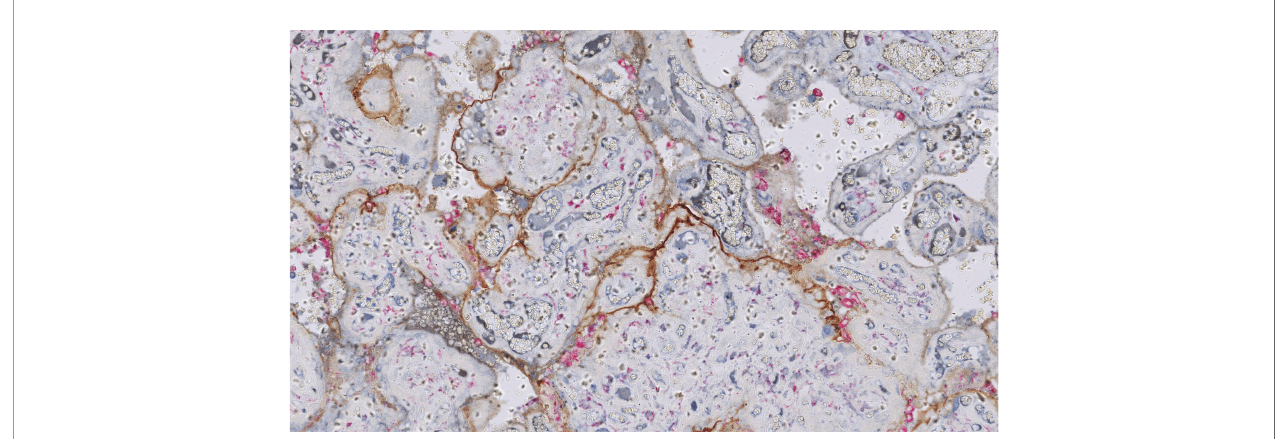
FIGURE 4 | Chronic histiocytic intervillositis (CHI). Dual staining demonstrates aggregates of CD68+ histiocytes in the intervillous space (pink) and linear deposition of C4d along the microvillous border (brown) in a case requiring delivery by emergency Caesarean section for severe fetal growth restriction with abnormal umbilical artery Dopplers at 24 weeks ’ gestation. Histology also showed extensive perivillous fi brin